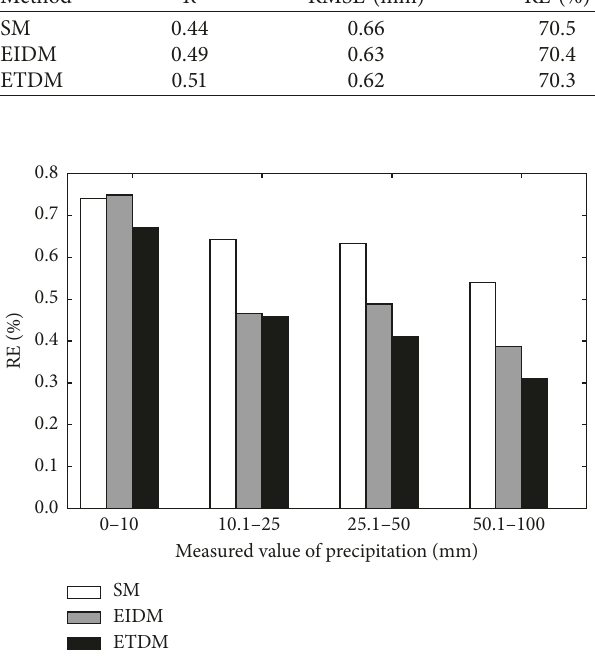
Figure 7: Relative error (%) of RQPE determined from the SM, EIDM, and ETDM